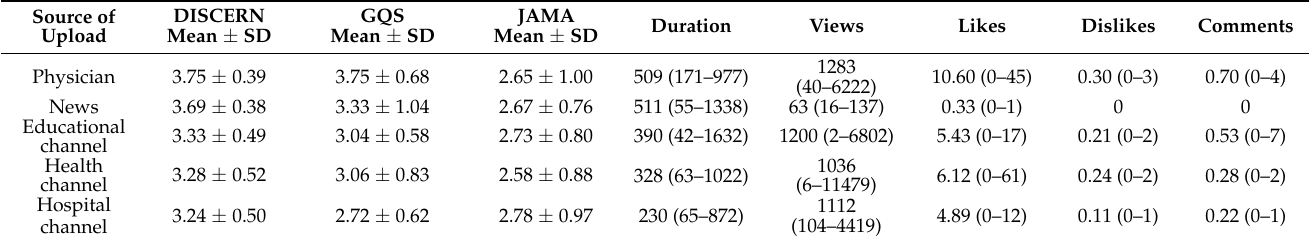
Table 5. The characteristics of videos according to source of uploading groups.